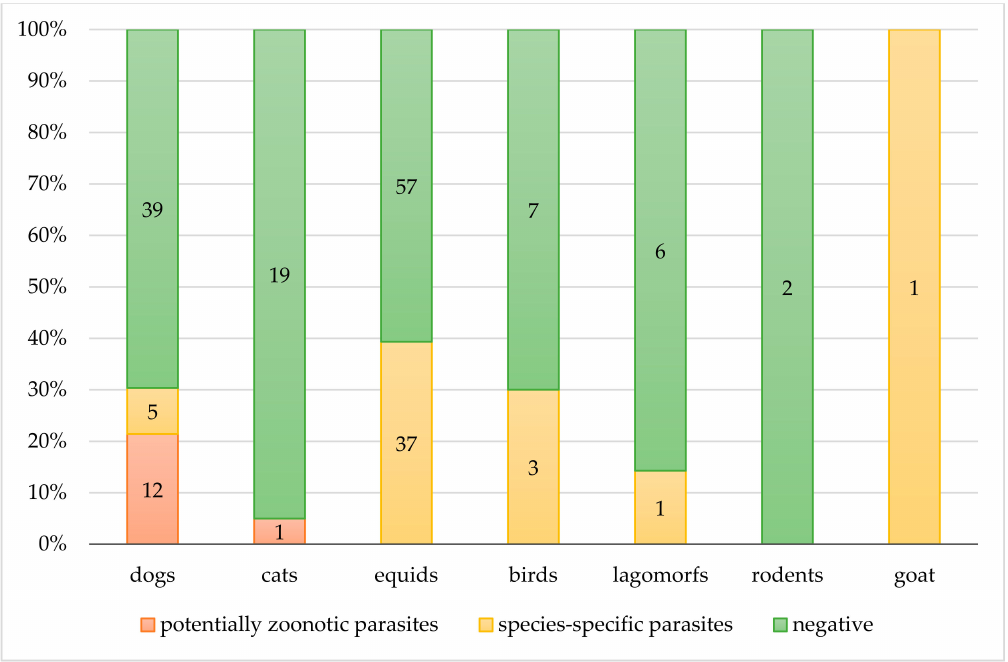
Figure 3. Copromicroscopic results. Distribution of negative and positive (zoonotic or species-specific) results in each animal